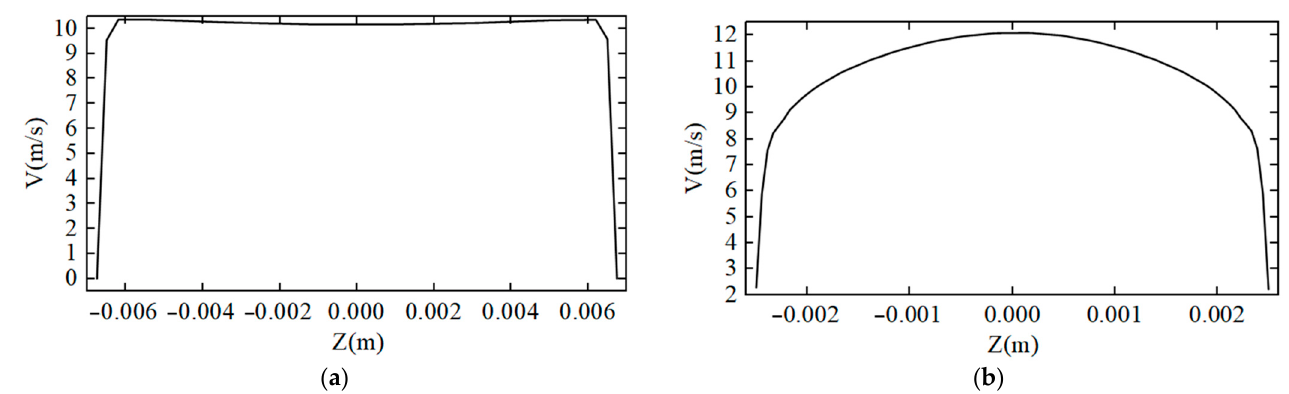
Figure 3. ( a ) Background velocity curve of laminar fluid state; ( b ) Background velocity curve of turbulent fluid state.